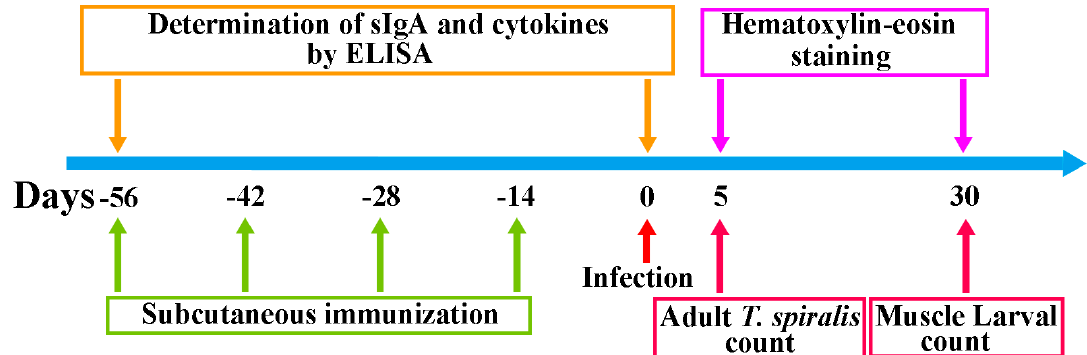
Figure 1. Scheme of immunization and measure protocol. Subcutaneously immunization of mice was administered four times (days-56, -42, -28 and -14) at a 2-week interval before orally challenged with 300 T. spiralis ML on day 0. At day 5 and 30 after challenge, intestinal adult worm and muscle larval burden (larvae per gram, LPG) were respectively assessed to evaluate the immune protection induced by the rTsT immunization. Histopathological examination of muscle and intestines from infected mice was also performed at day 5 and 30 after larval challenge infection.